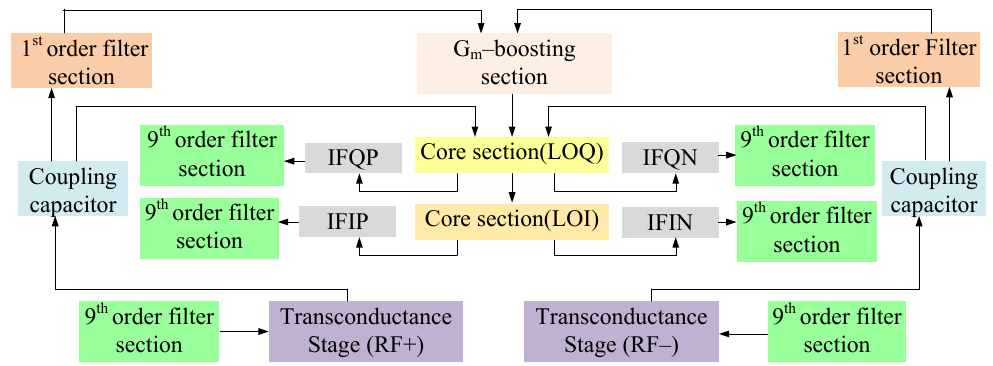
Figure 3. Block diagram of the proposed